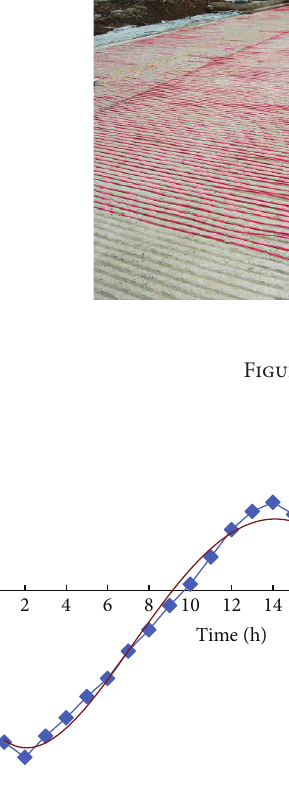
Figure 9: Air temperature curve at the test site.